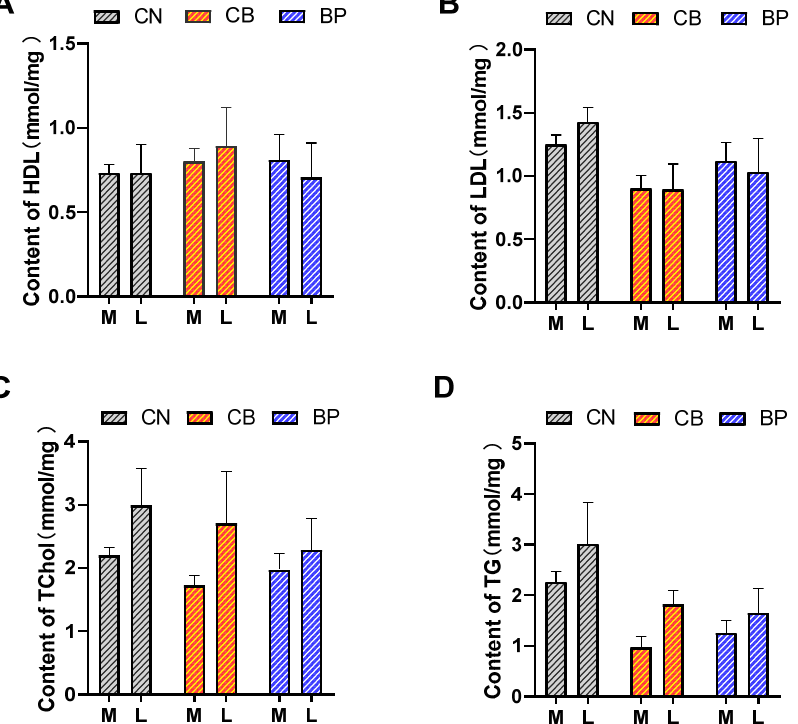
Figure 1. Effects of CN, CB, and BP on serum parameters in rabbits. ( A – D ) Serum concentrations of HDL, LDL, Tchol, and TG at the middle phase (M = 21 days) and later phase (L = 42 days). CN, rabbits were fed a basal diet; CB, rabbits were fed a basal diet supplemented with Clostridium butyricum ; BP, rabbits were fed a basal diet supplemented with a bacteriophage cocktail. HDL, high-density lipoprotein; LDL, low density; Tchol, total cholesterol; TG, triglyceride; (values are expressed as the mean ± SE, n = 8)